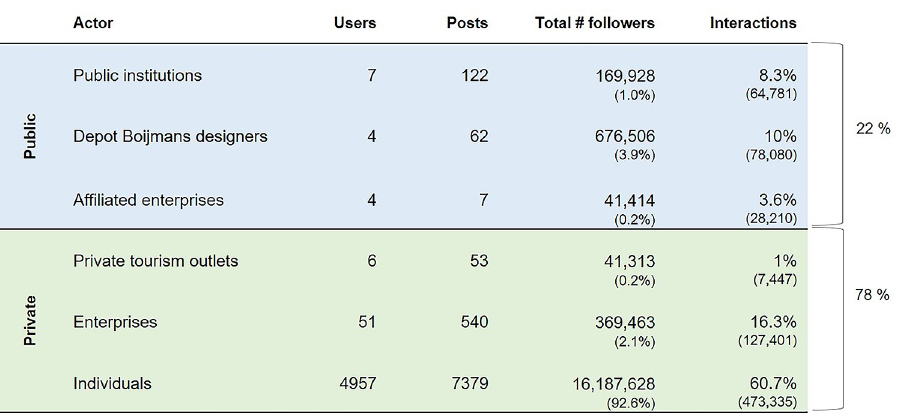
Fig 5. Actors and dataset interactions (by